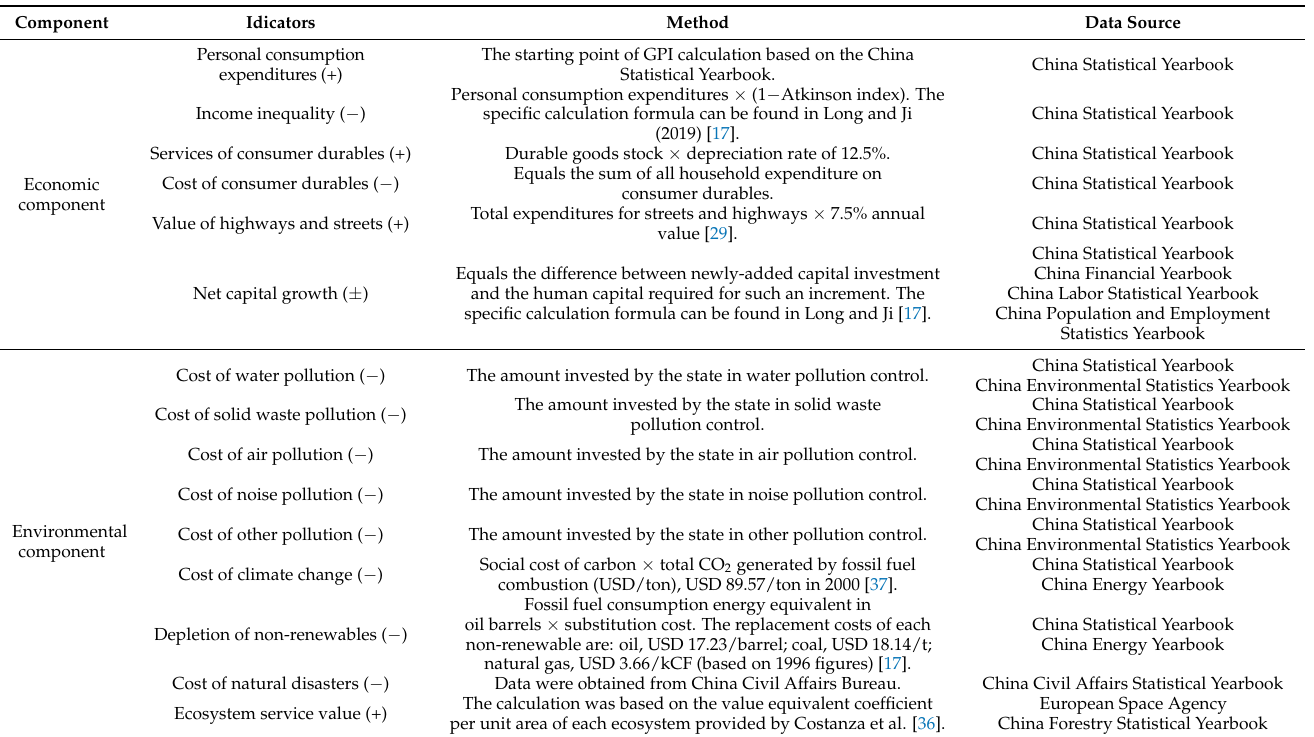
Table 2. Description of indicators and calculation processes of revised